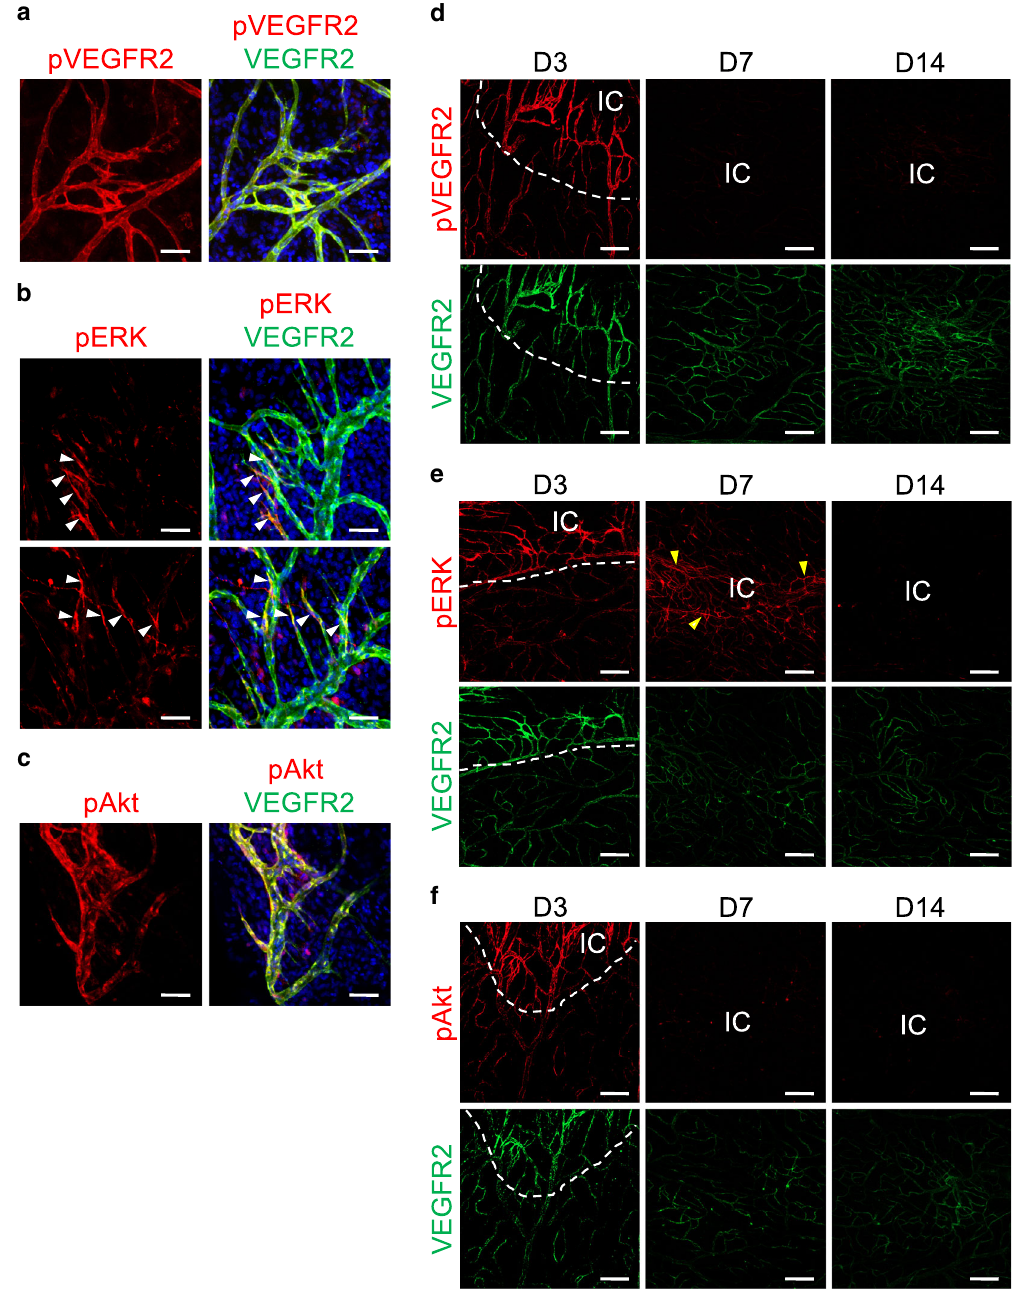
Fig. 3 Spatiotemporal changes of pVEGFR2, pERK, and pAkt in VEGFR2 + blood vessels during vascular regeneration in dura mater after PTI. a – c Representative images of phosphorylated VEGFR2, ERK (white arrowheads), and Akt in regenerating BVs of the dura mater at D3 after PTI in adult mice. Scale bars, 50 µ m. Similar fi ndings were observed in four mice from two independent experiments. d – f Representative images of pVEGFR2, pERK, and pAkt in VEGFR2 + BVs of surrounding BVs of putative injury area (white dotted line) or injury core (IC) at D3, D7, and D14 after PTI in adult mice. Similar fi ndings were observed in n = 3 mice from two independent experiments. Scale bars, 200 µ m. Note that pERK remains elevated at D7 (yellow arrowheads) before returning to basal levels by